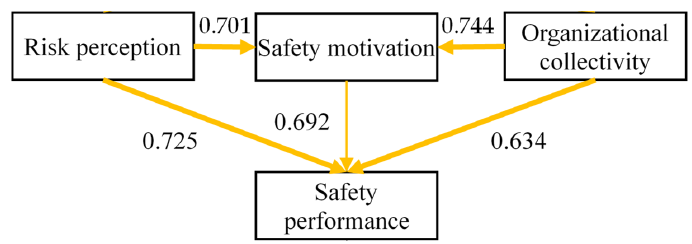
Figure 4. Structural equation modeling of SP in Hong Kong. Table 8. Significance of path impact among safety constructs in